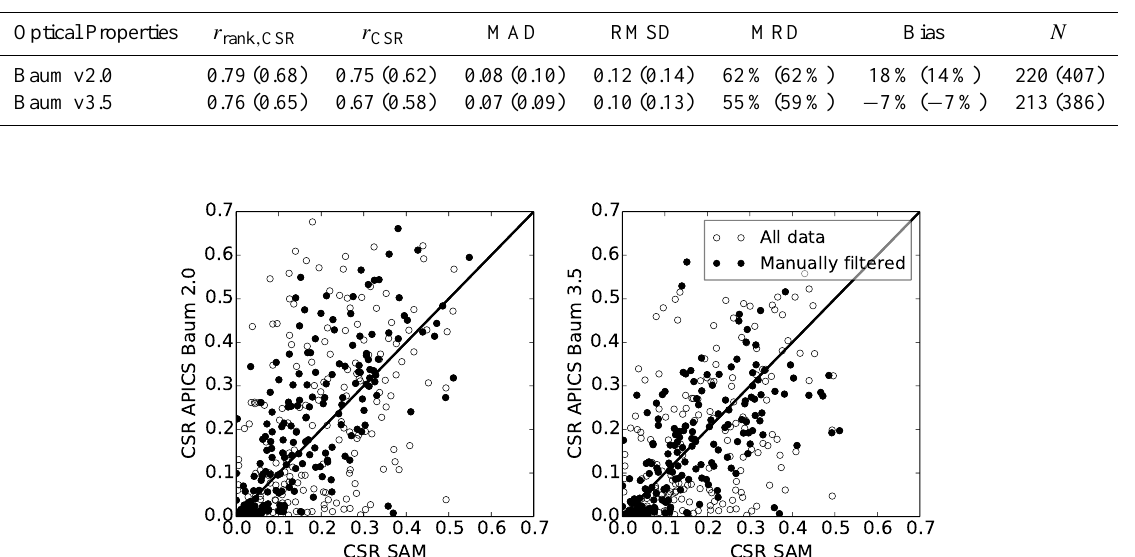
Table 3. Same as Table 2 but for the shortened time series (1 May 2011–30 June 2011) which was manually cumulus-screened. Values in parenthesis are for unscreened time series.